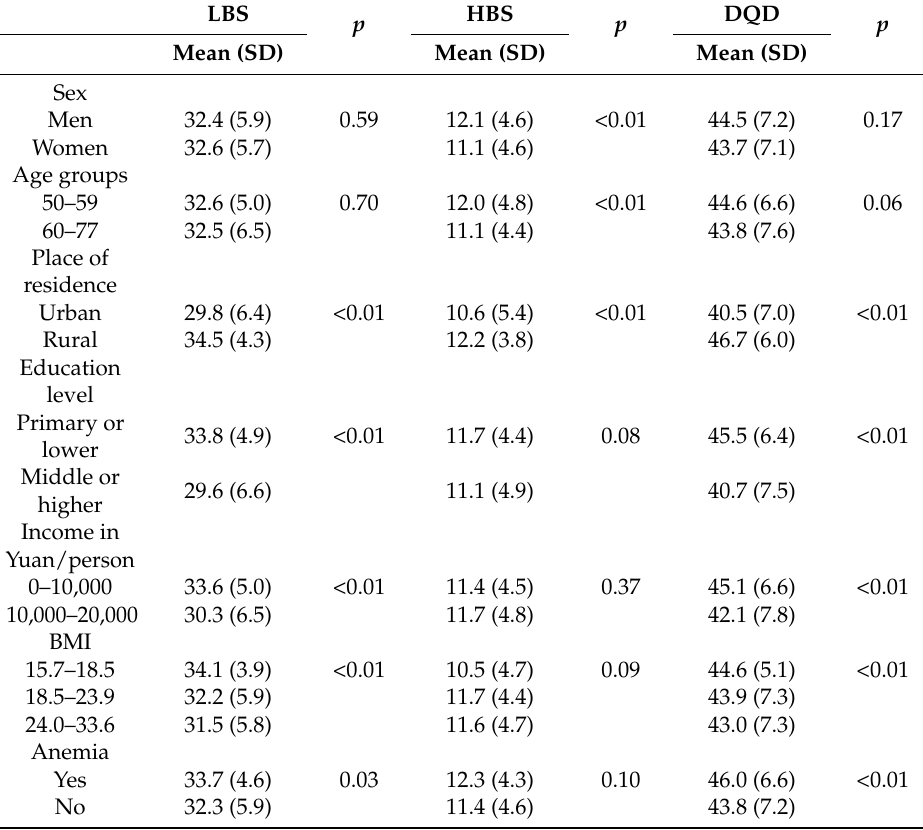
Table 5. DBI-07 indicators by